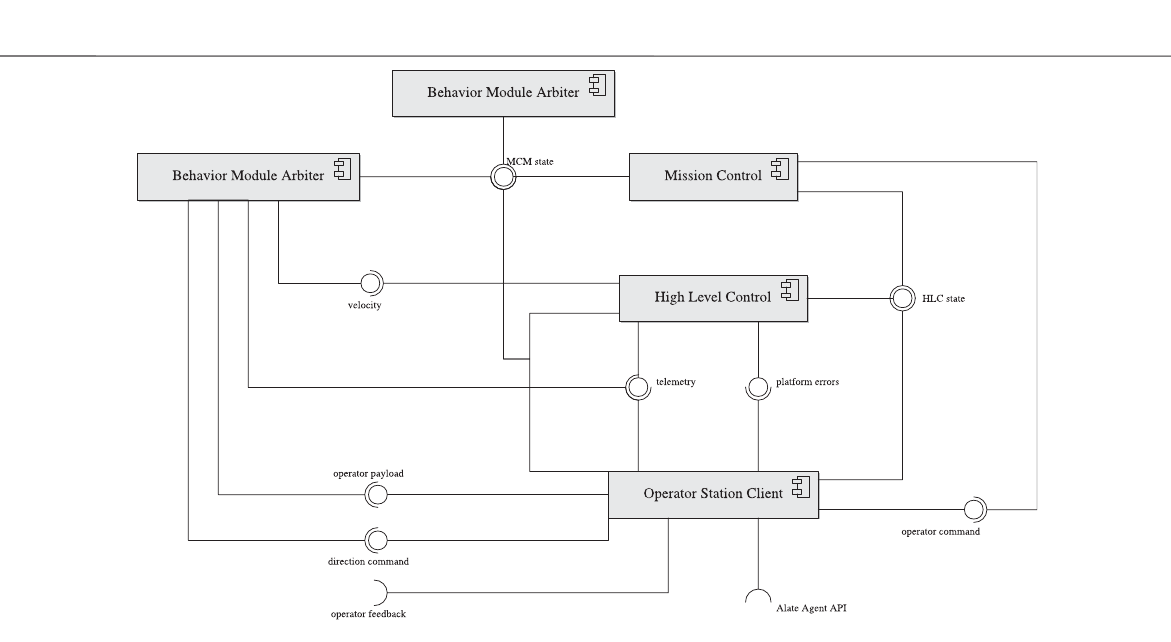
FIGURE 10 | AntAlate template application